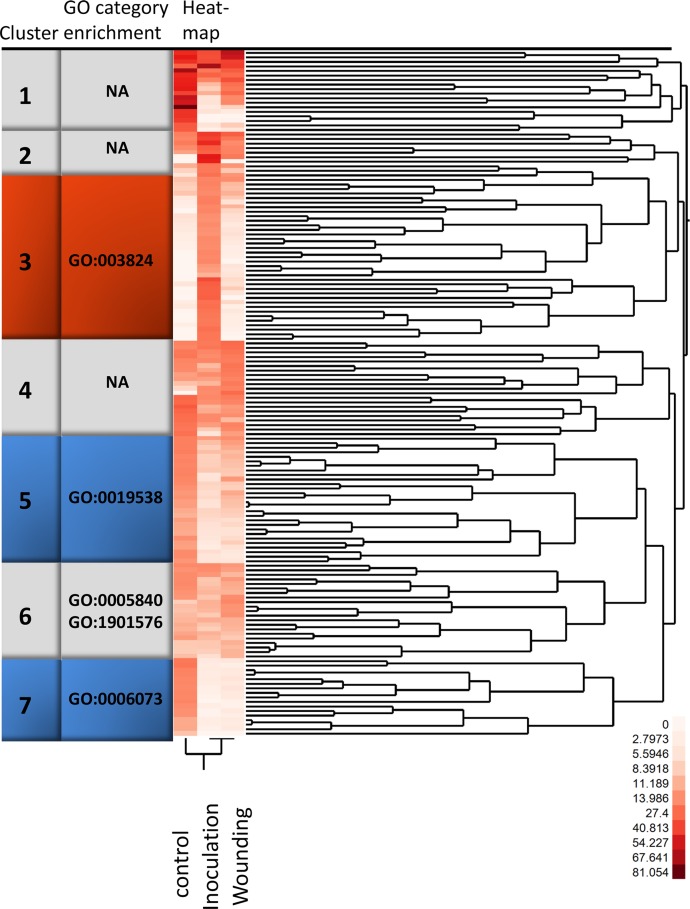
Two-way clustering of the 150 most highly expressed transcripts.A two–way clustering of normalized 454 sequence count data using Ward’s hierarchical cluster algorithm. The increasing intensity of red in the heat map visualise counts from white (no counts in the particular condition) to red. Clusters are indicated by numbers and the enriched GO categories are noted for each cluster. Clusters containing significantly regulated genes are highlighted in colour, with orange for cluster 3, containing genes significantly induced in inoculated samples and blue for clusters with genes more highly expressed in control than in wounding. Please refer to S4 Table for information about specific isotigs found in the clusters.